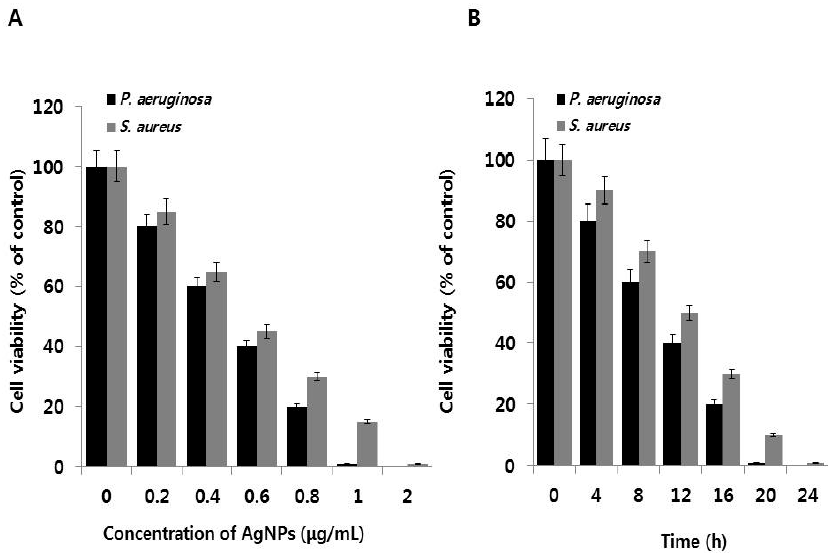
Figure 2. Effect of AgNPs on cell viability: ( A ) P. aeruginosa and S. aureus cells were incubated with various concentrations of AgNPs. Bacterial survival was determined at 24 h based on a CFU count assay; ( B ) Time dependent effect of AgNPs on P. aeruginosa and S. aureus . The experiment was performed with various controls, including a positive control (AgNPs and MHB, without inoculum) and a negative control (MHB and inoculum, without AgNPs). Results are expressed as the means ± SD of